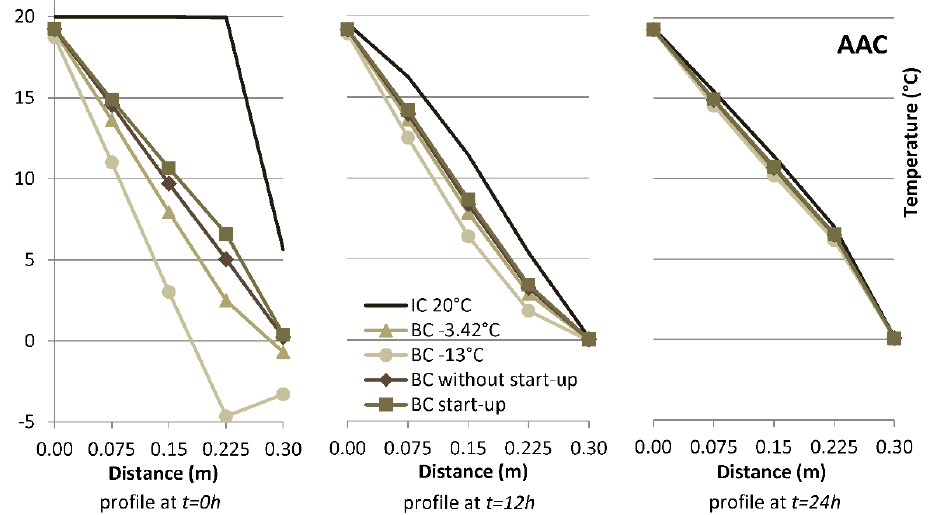
Figure 11. Temperature profile across the simple AAC test wall at time t = 0 h, t = 12 h and t = 24 h for five cases under the initial condition. Abbreviations IC and BC refers to Section 2.4.